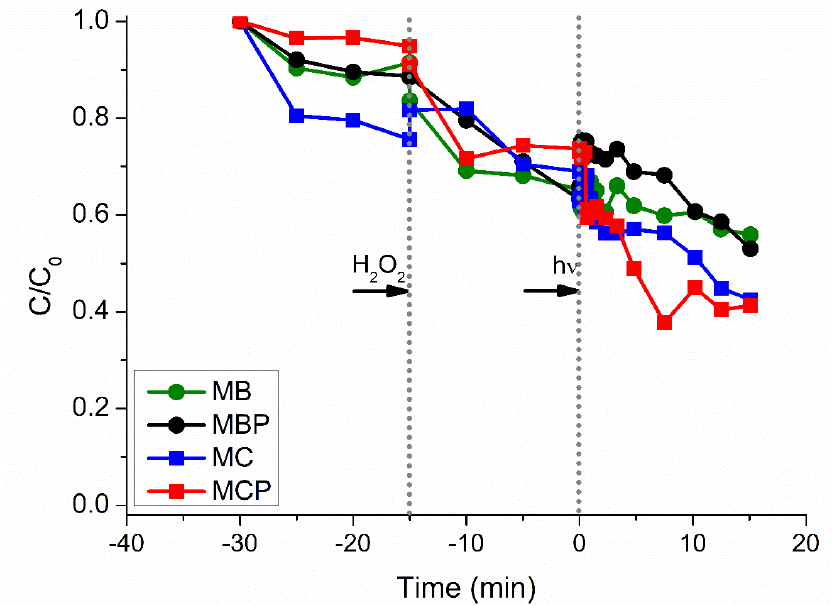
Figure 7. DCF concentration (C 0 = 20 mg L − 1 ) profiles against the four different materials using sunlight as the irradiation source. Data reported consider a final concentration of materials of 500 mg L − 1 and final time of 45 min. Legend: MB green circles, MBP black circles, MC blue squares, MCP red squares. Vertical grey dotted lines evidenced the two steps, namely (i) introduction of H 2 O 2 , and (ii) beginning of the irradiation process.